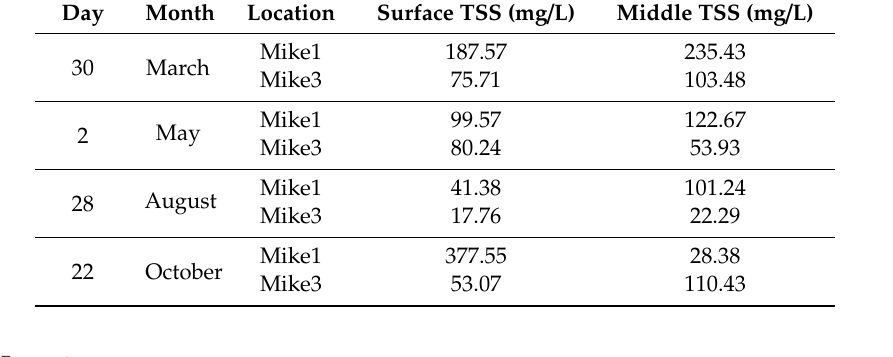
Table 2. Total suspended solids (TSS) concentrations in the surface and middle water column sampled in March, May, August and October 2015 at both Mike1 and Mike3 stations.